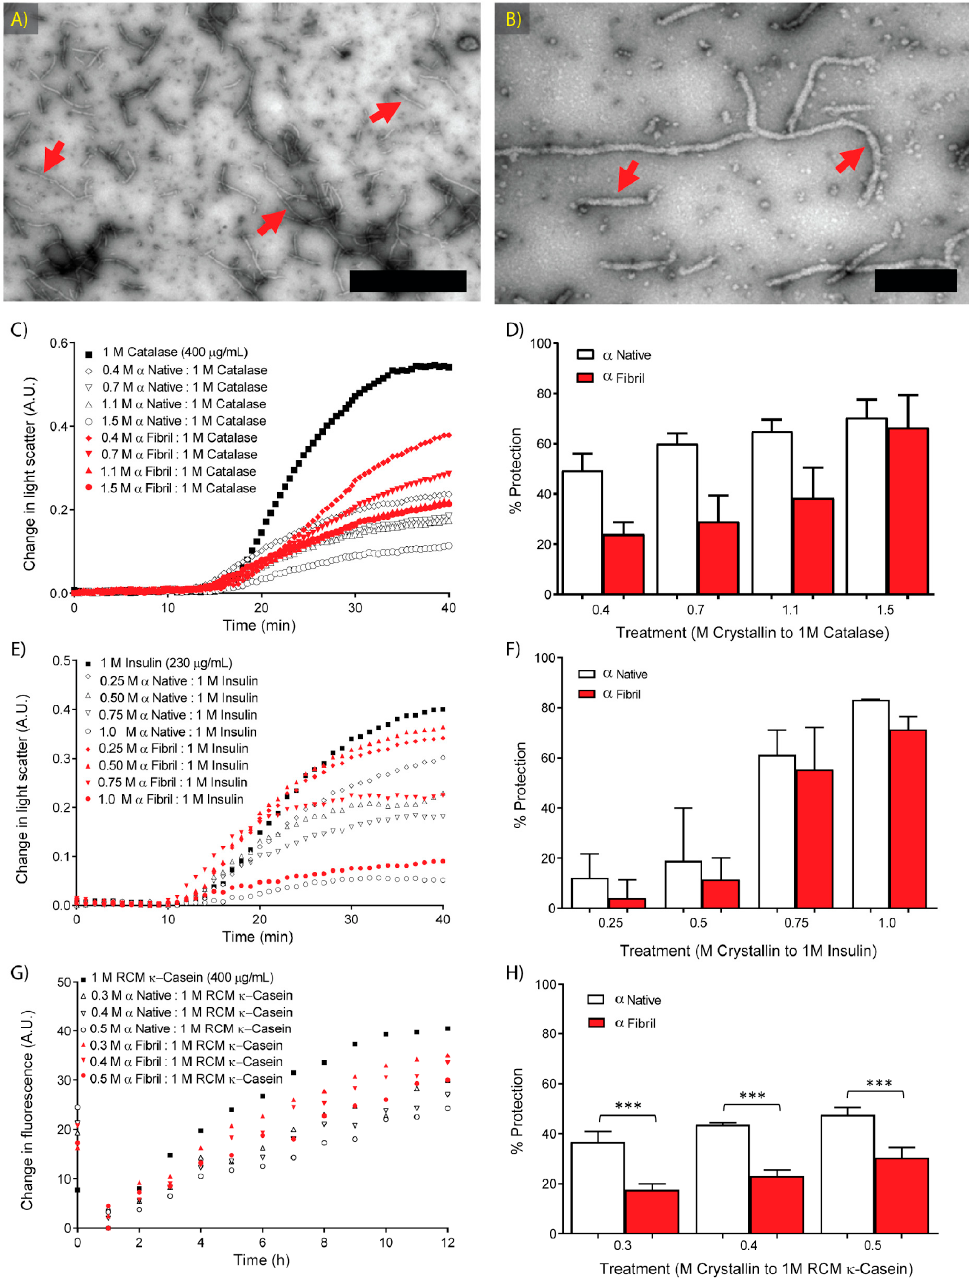
Figure 1. Fibril formation and chaperone activity of native and fibrillar α -crystallin. ( A , B ) Transmission electron micrographs of α -crystallin fibrils formed in 1 M guanidine hydrochloride (GdnHCl), 0.1 M sodium phosphate, pH 7.4 at 60 ◦ C for 2 h, with red arrows indicating fibril structures. Scale bars are: ( A ) 1 µ m and ( B ) 200 nm; ( C – H ) Native and fibrillar α -crystallin chaperone protection of ( C , D ) catalase at 400 µ g/mL in 0.1 M sodium phosphate buffer at pH 7.4, undergoing thermal destabilisation at 60 ◦ C; ( E , F ) reduced insulin, 230 µ g/mL in 0.1 M sodium phosphate buffer pH 7.4, at 37 ◦ C in the presence of 10 mM 1,4-dithiothreitol (DTT); and ( G , H ) reduced and carboxymethylated (RCM) κ -casein, 400 µ g/mL incubated at 37 ◦ C in 0.1 M sodium phosphate, 10 µ M thioflavin T (ThT) for 12 h; ( C , E , G ) show representative profiles of light scattering; ( D , F , H ) show the percentage of protection provided by each chaperone, calculated from the difference between the maximum light scattering or fluorescence of the target protein alone and the target protein in the presence of the stated concentrations of α -crystallin. Data shown are means ± standard error (SE) of ( D , F ) three or ( H ) of six separate experiments; p- values indicating significant difference from two-way ANOVA (Šid á k post-hoc test) are: *** p <